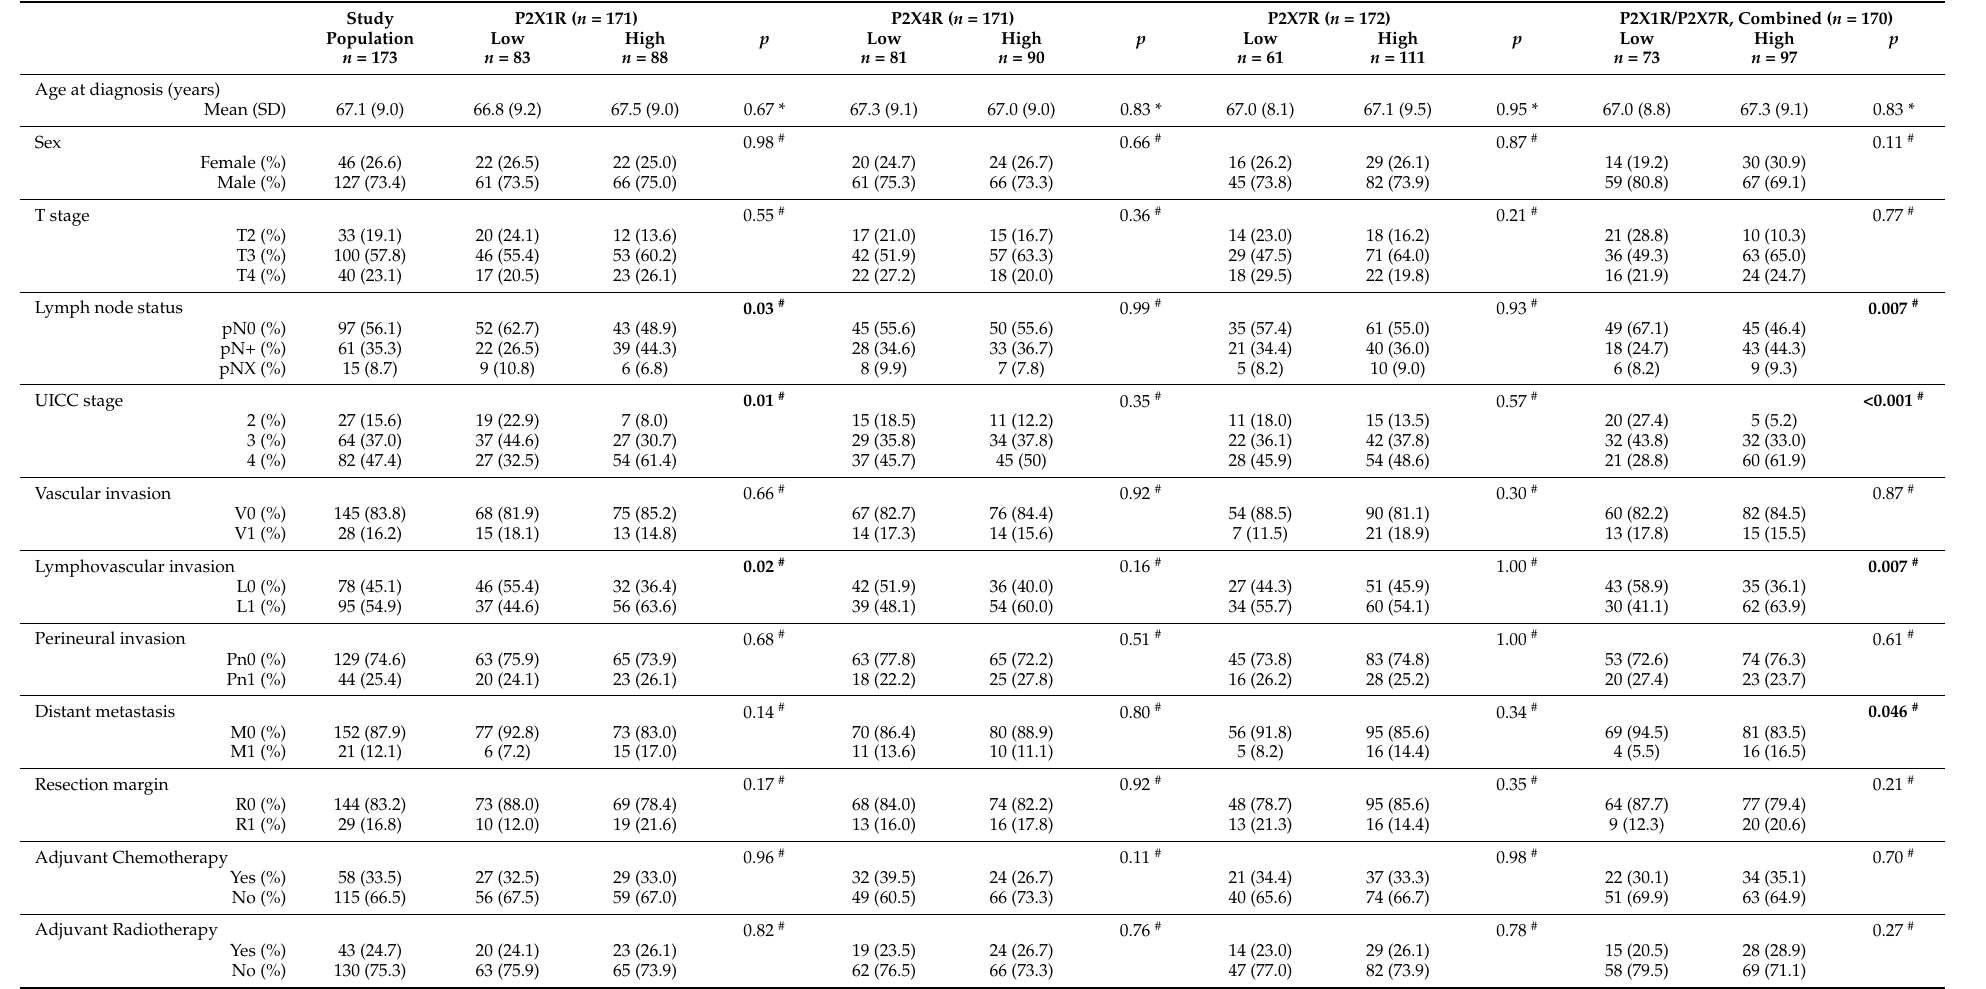
Table 1. Demographics, clinicopathological characteristics, and associations with P2X1, P2X4, and P2X7 receptor